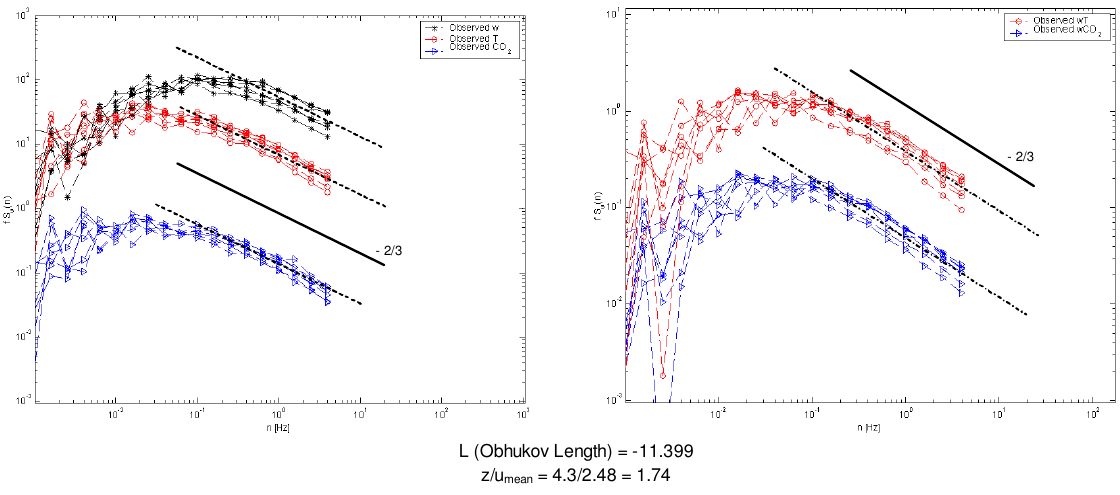
Fig. 2. Power-spectra of w , T and CO 2 -concentration (left) and co-spectra of w 0 T 0 and w 0 CO 2 0 (right) for 10Hz eddy covariance data of seven half hours in spring 2005. Data are averaged per half hour. Figure 3: Diurnal pattern of energy balance components net radiation, latent heat, sensible heat and ground heat flux and CO 2 flux for seven days in spring 2005.